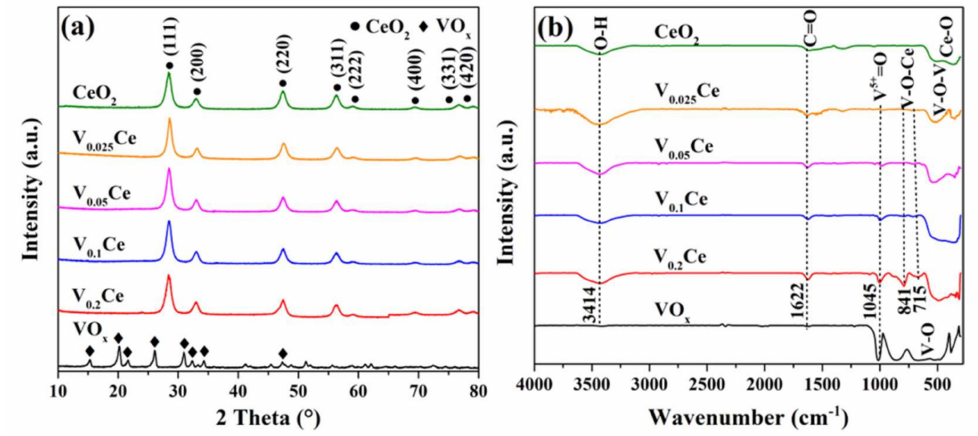
Figure 1. ( a ) X-ray diffraction (XRD) profiles and ( b ) Fourier transform infrared spectra (FT–IR) of prepared